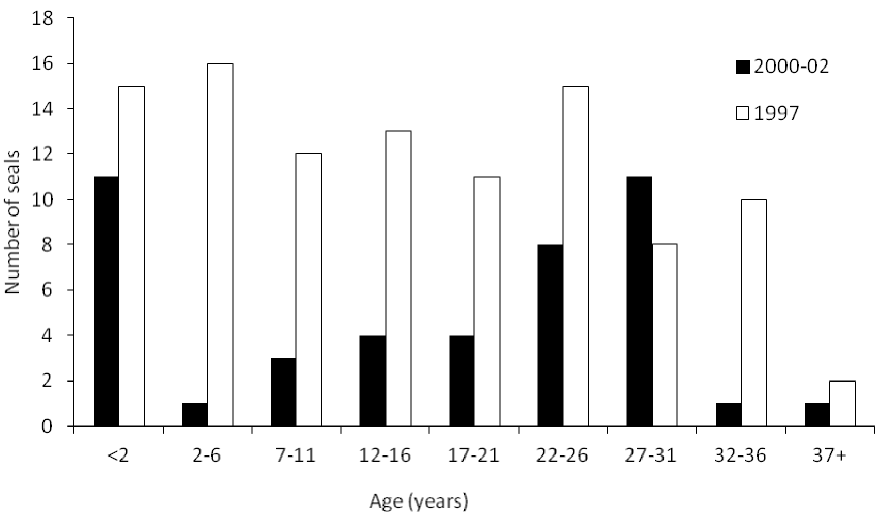
Figure 4. Histogram of age structure among Caspian seal carcases stranded 1999–2002.